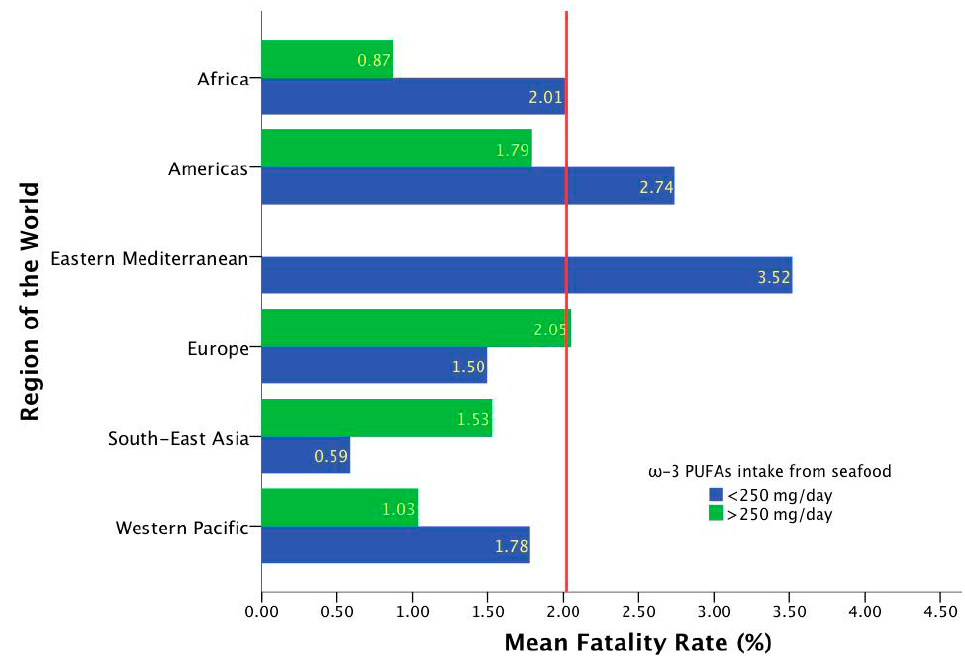
Figure 4. Mean fatality rates according to the region and ω -3 PUFA intake from seafood. The red line represents the global fatality rate (2.02%). Linear regression model considering region and ω -3 PUFA intake: r = 167; r 2 = 0.028; p = 0.074.